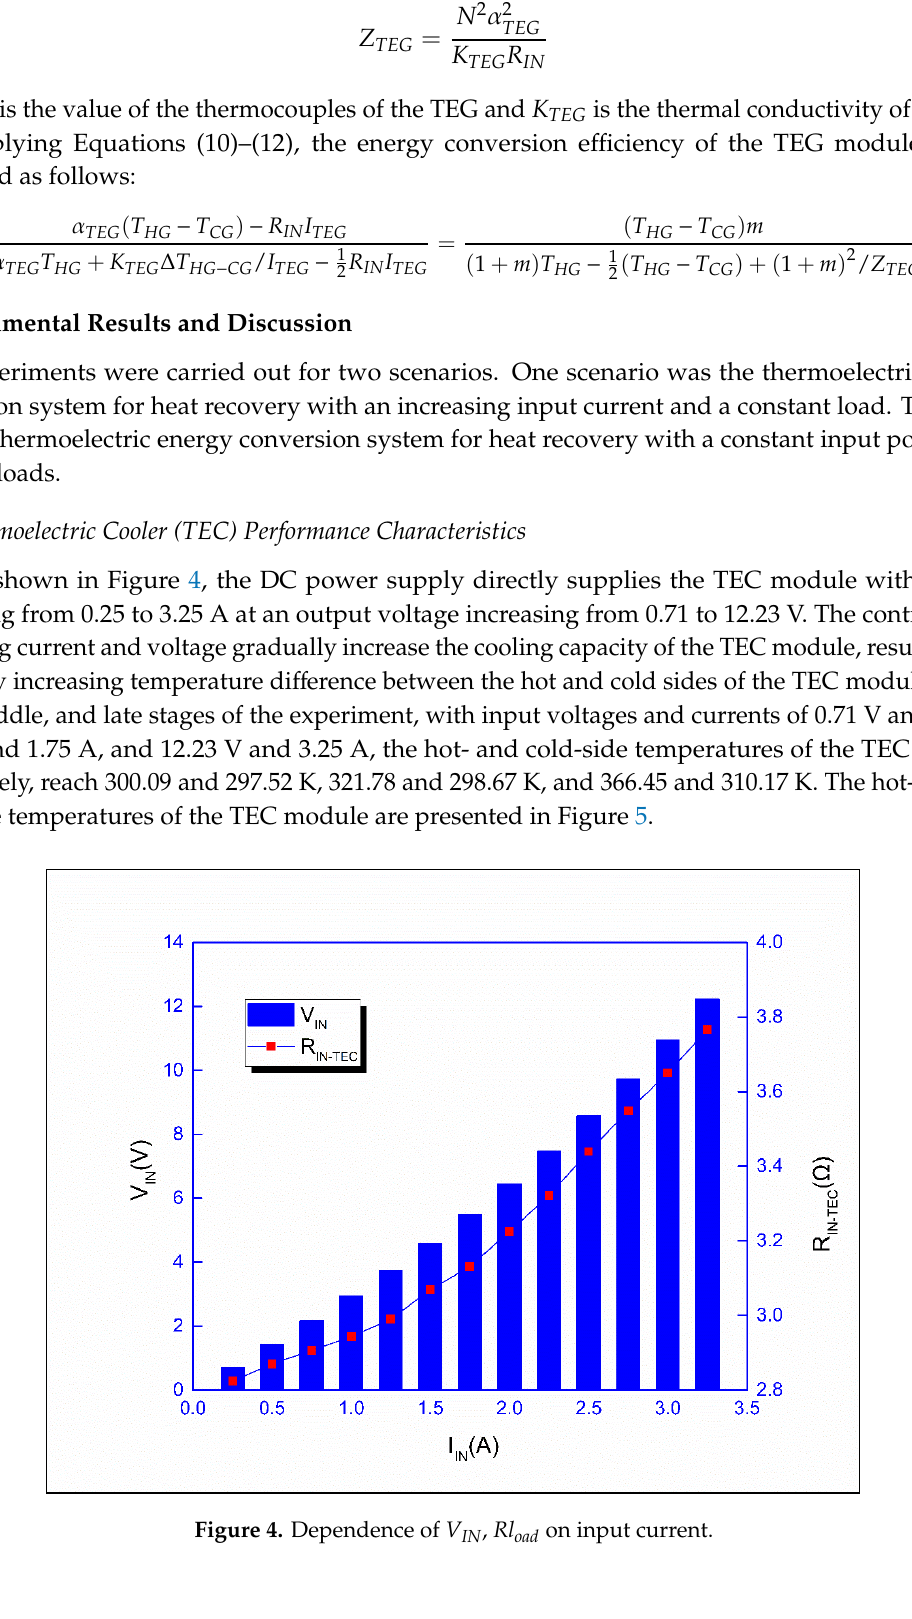
Figure 5. Dependence of